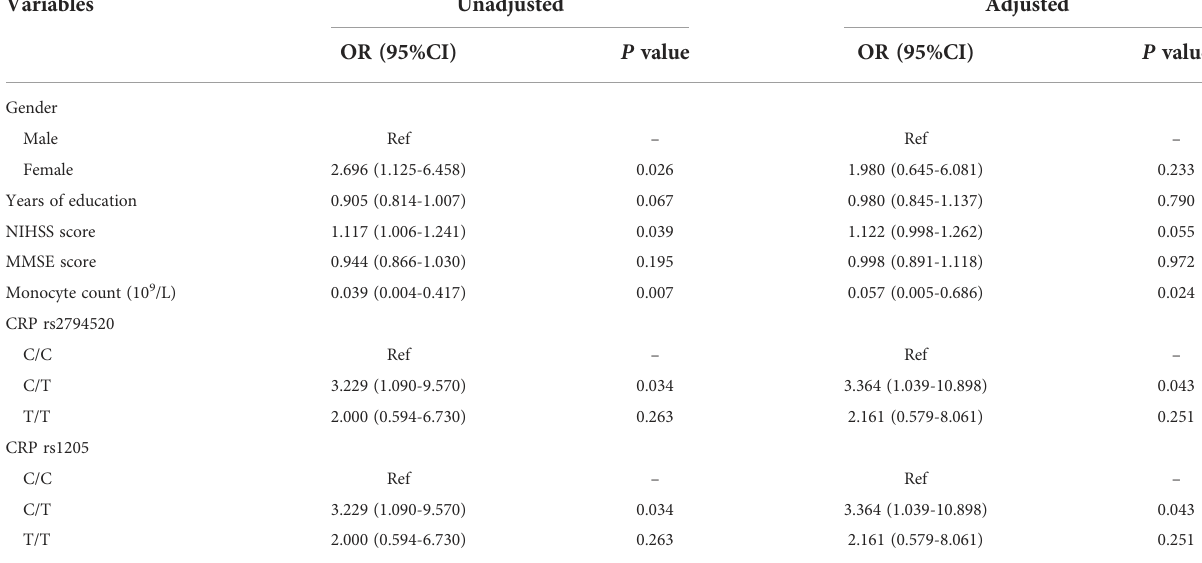
TABLE 2 Independent risk factors of